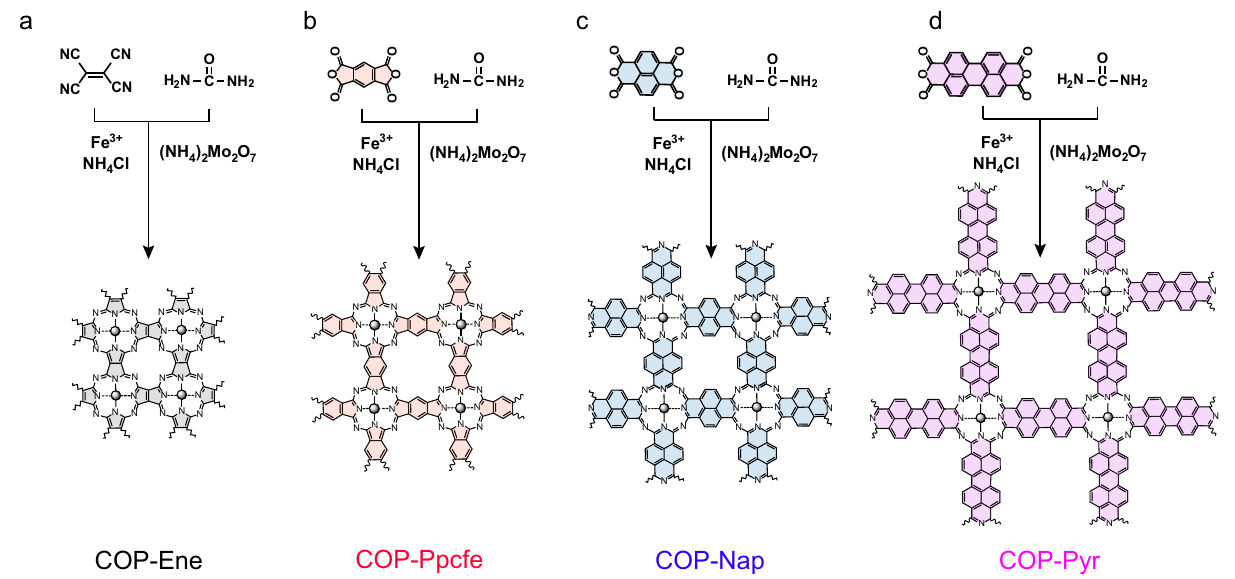
Fig. 1 Synthesis routes of four full π -conjugated covalent organic polymers (COPs). a – d Scheme of formation towards COP-Ene, COP-Ppcfe, COP-Nap, and COP-Pyr samples by tailoring monomers constructed corresponding building